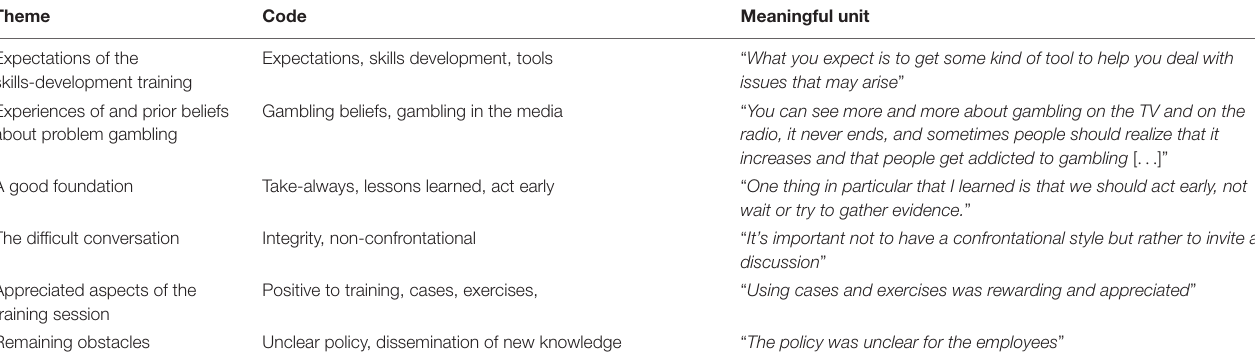
TABLE 1 | Examples of how themes and codes were derived from meaning